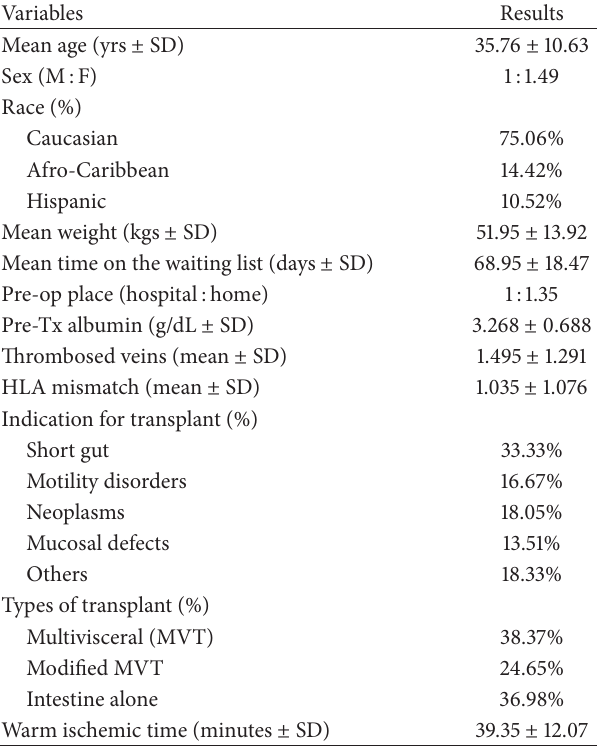
Table 3: Recipient demographics.